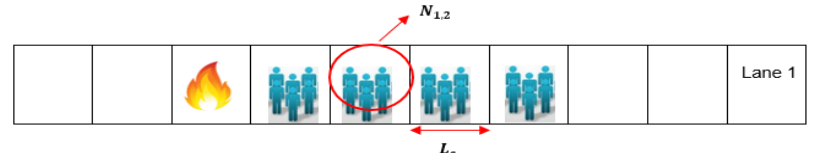
Figure 2. Distribution of users in cells adopted from [24]. Figure 3 appears below: